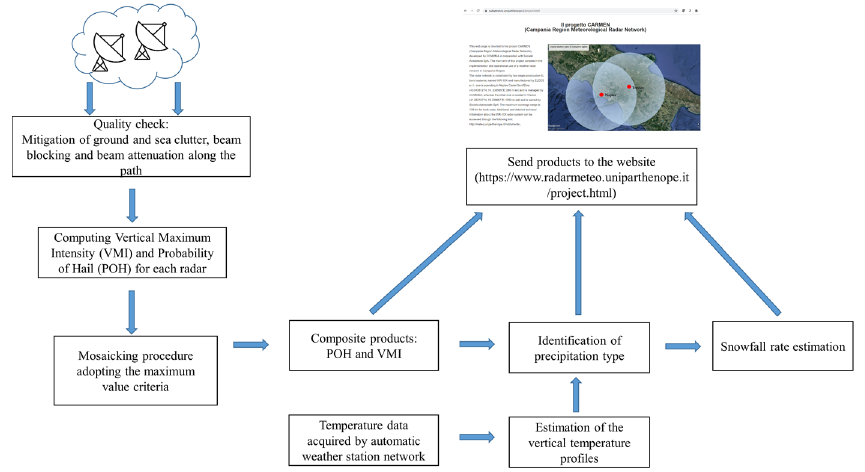
Figure 9. Real-time dataflow architecture of the CARMEN project X-band radar network.